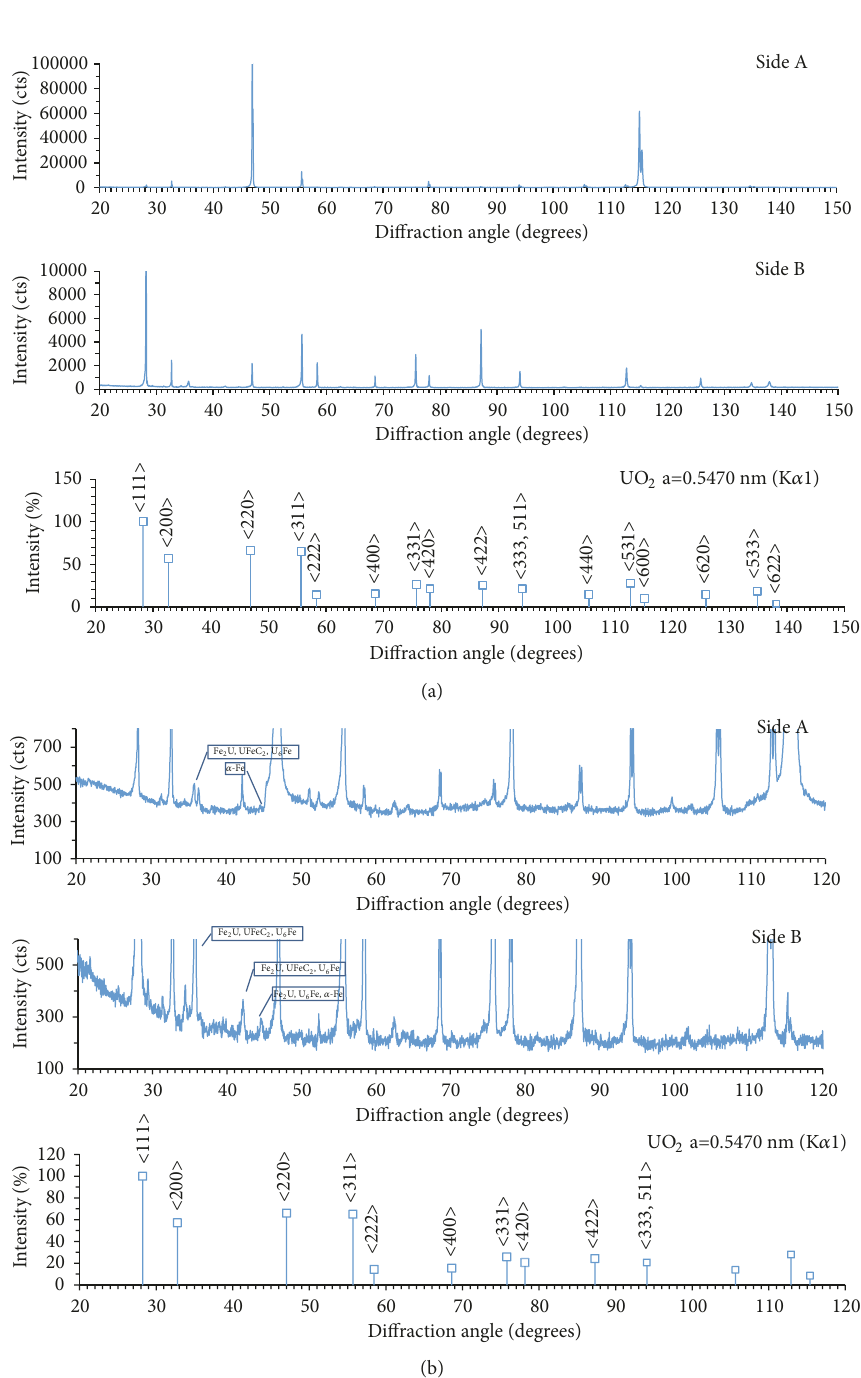
Figure 7: Diffraction pattern with identified peaks ( 1 , in full scale; b, for low intensity